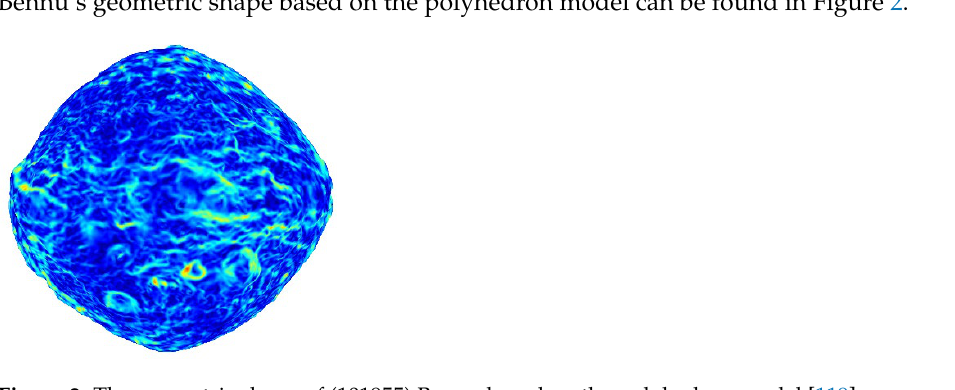
Figure 2. The geometric shape of (101955) Bennu based on the polyhedron model [119].